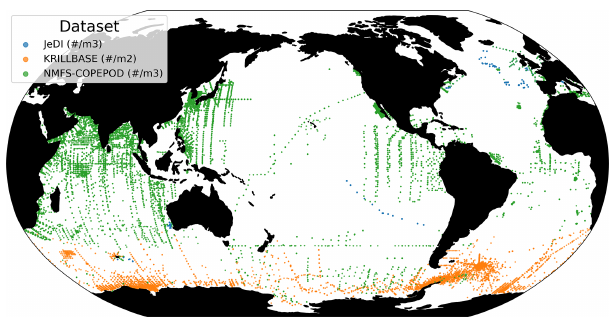
Figure A1. Map of the FFGM observations in the AtlantECO prod- uct. Colors indicate the original dataset.